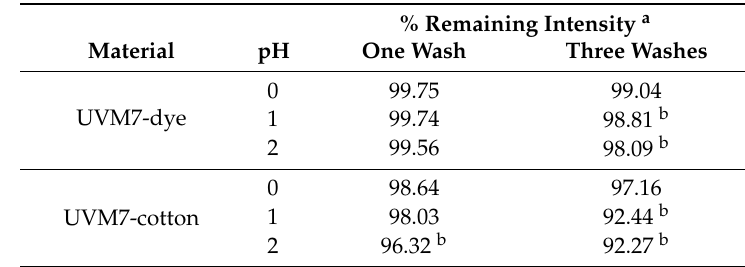
Table 1. The remaining intensity for UVM7-dye and UVM7-cotton at diverse pH values after one or three washes, considering that the response of the non-washed material at a certain pH has a value of